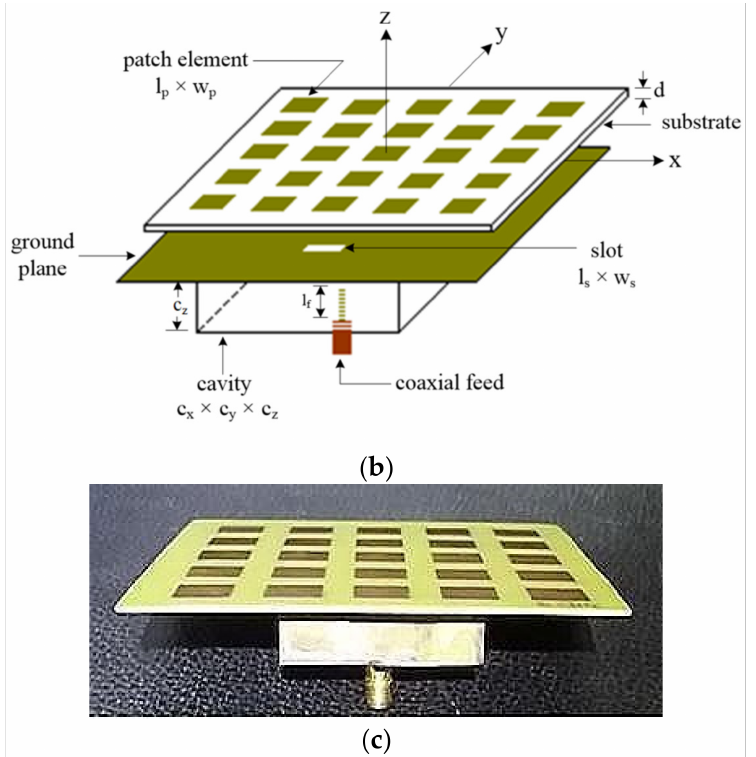
Figure 1. The configuration of the proposed antenna: ( a ) top view; ( b ) perspective view; ( c ) photo- graph of the fabricated antenna